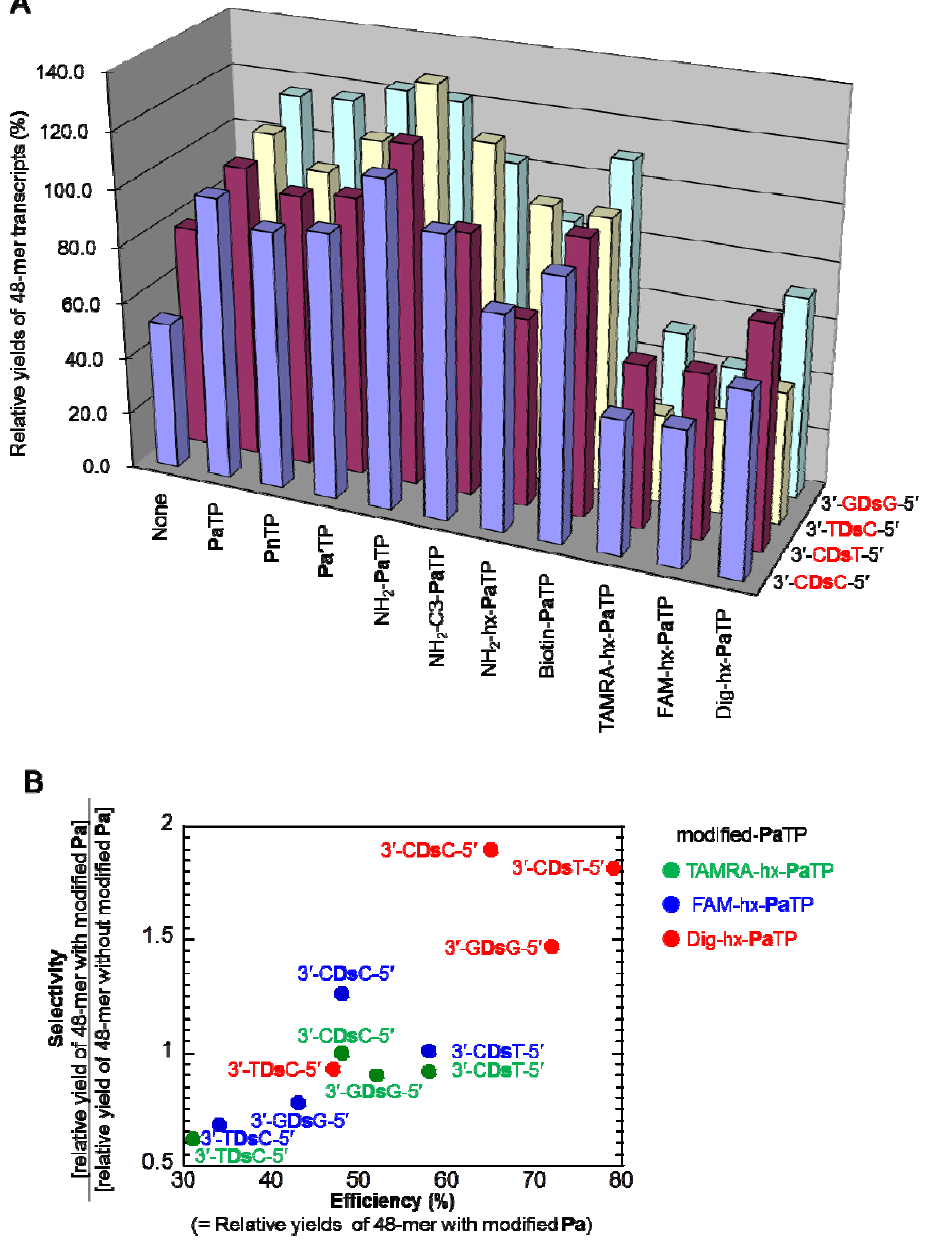
Figure 3. Efficiency and selectivity analysis of the 48-mer transcripts. (a) Plot of relative yields of the 48-mer transcripts from templates containing 3 ′ -C Ds C-5 ′ , 3 ′ -C Ds T-5 ′ , 3 ′ -T Ds C-5 ′ , or 3 ′ -G Ds G-5 ′ , in the presence of each modified- Pa TP or Pn TP. The relative yield of each full-length transcript was determined by comparison to the yield of the native transcript from the template consisting of the natural bases only (3 ′ -N Ds N -5 ′ = 3 ′ -CAT-5 ′ 1 2 for 3 ′ -C Ds C-5 ′ , 3 ′ -C Ds T-5 ′ , 3 ′ -T Ds C-5 ′ ; 3 ′ -N Ds N -5 ′ = 3 ′ -GAG-5 ′ for 3 ′ -G Ds G-5 ′ ). The 1 2 values were averaged from three data sets. (b) Correlation between the incorporation efficiency and selectivity of Pa TPs modified with large molecules in T7 transcription. The selectivity was determined as the ratio of the relative yield of the 48-mer transcripts with and without modified- Pa bases (TAMRA-hx- Pa , FAM-hx- Pa , and Dig-hx- Pa ) from the gel analysis of